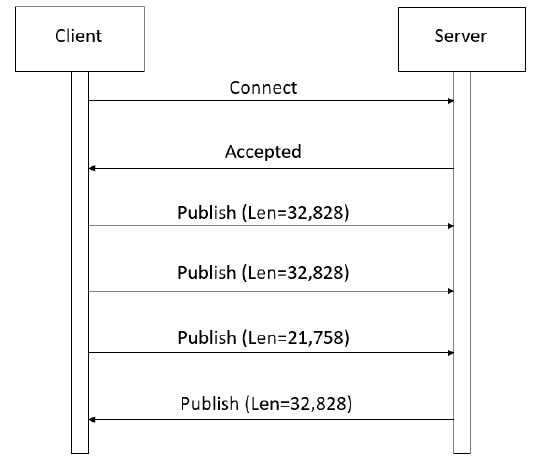
Figure 8. Flood attack.